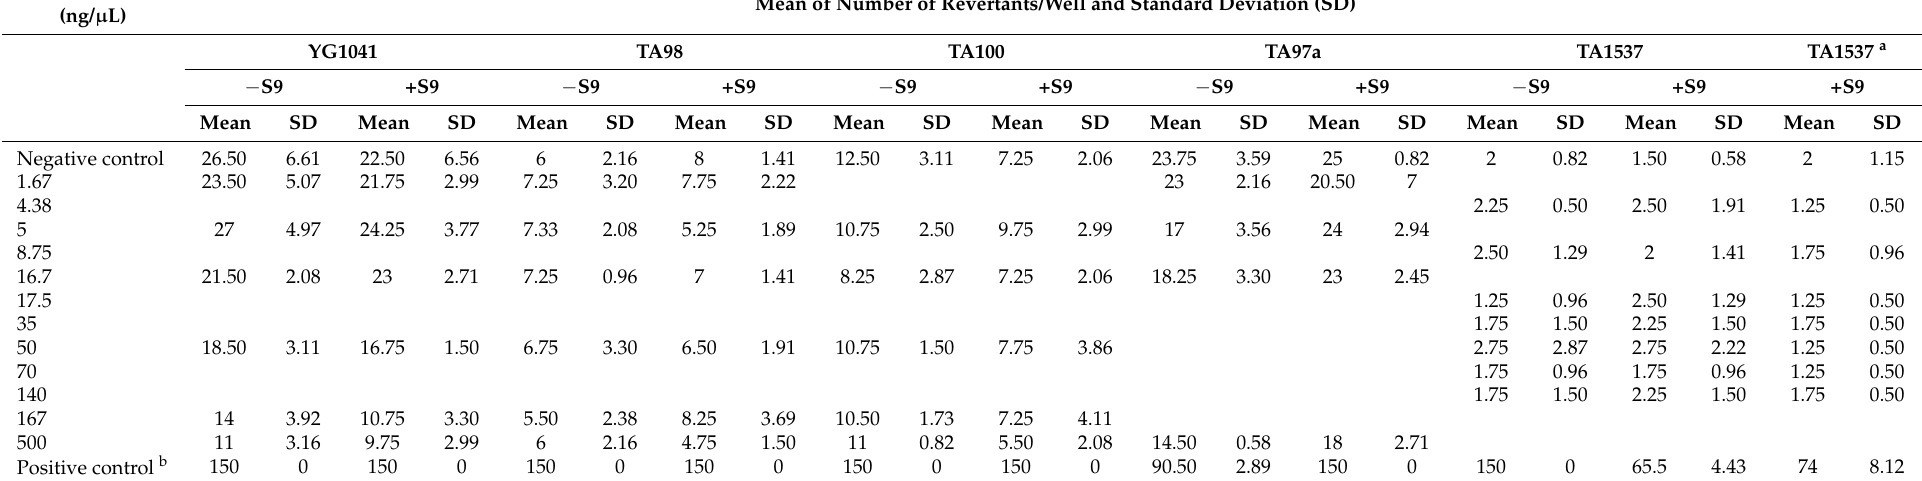
Table 3. Mutagenicity data for dermocybin with YG1041, TA98, TA100, TA97a, and TA1537 strains with and without S9.